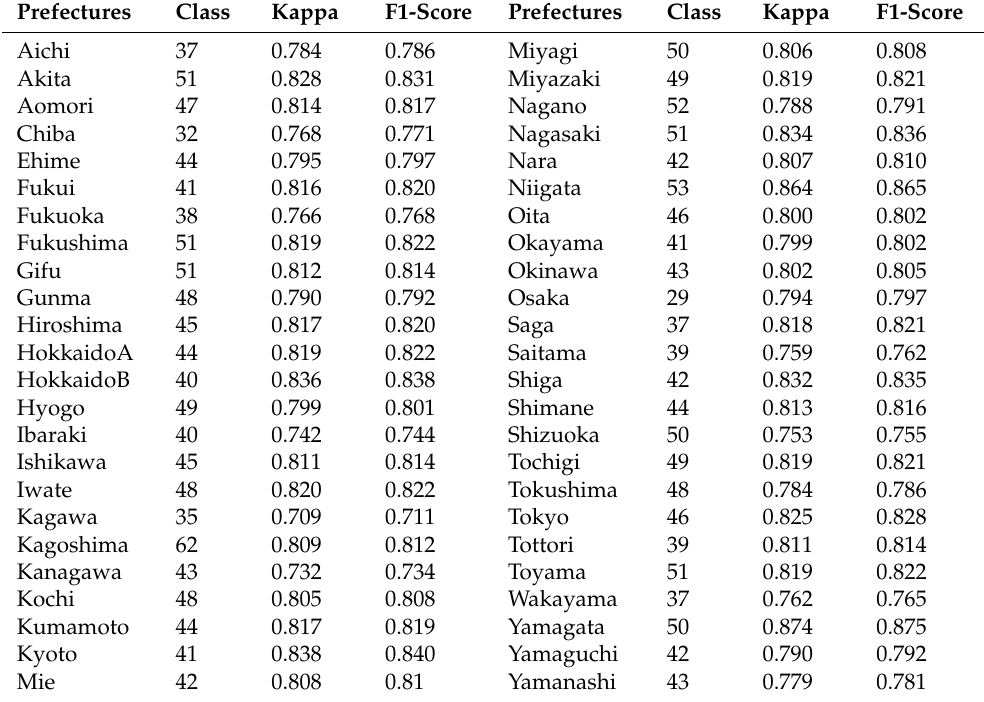
Table 4. Summary of the cross-validation accuracies calculated as average accuracies in terms of Kappa coefficient and F1-score across all classes in each prefectural